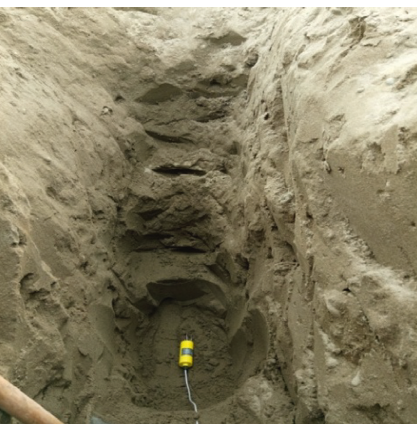
Figure 3: Temperature and humidity sensor embedded in the test section.